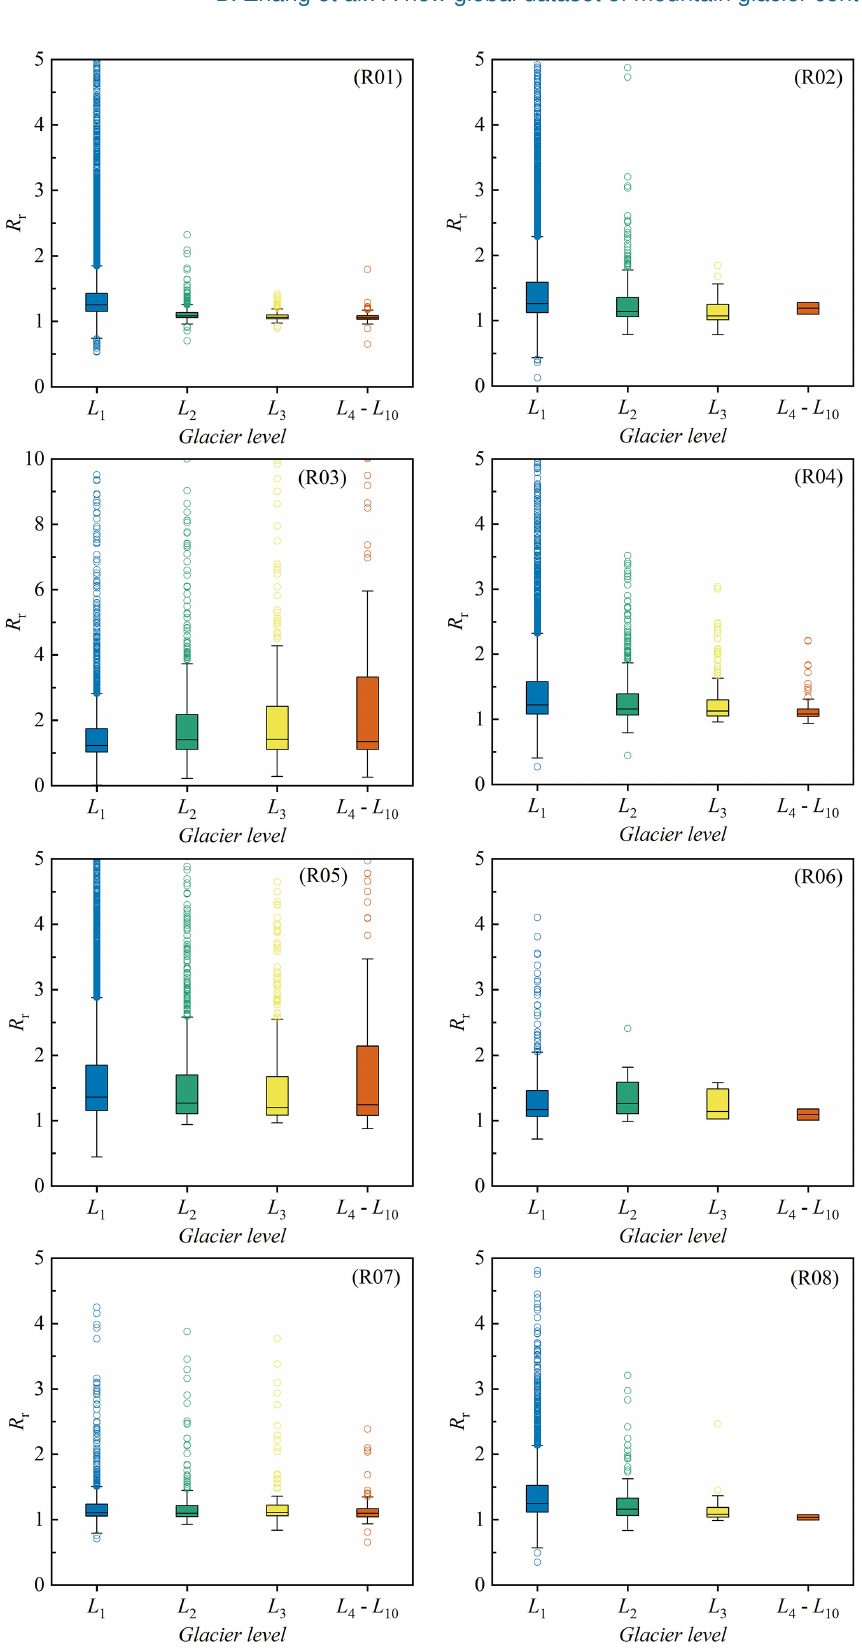
Figure B3. Earth Syst. Sci. Data, 14, 3889–3913,